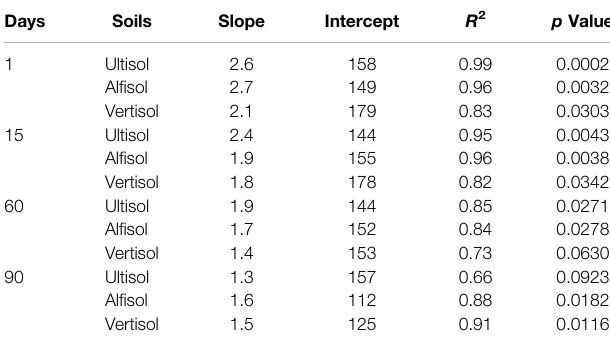
TABLE 5 | Linear regression statistics of moisture sensitivity of C acquiring extracellular enzyme